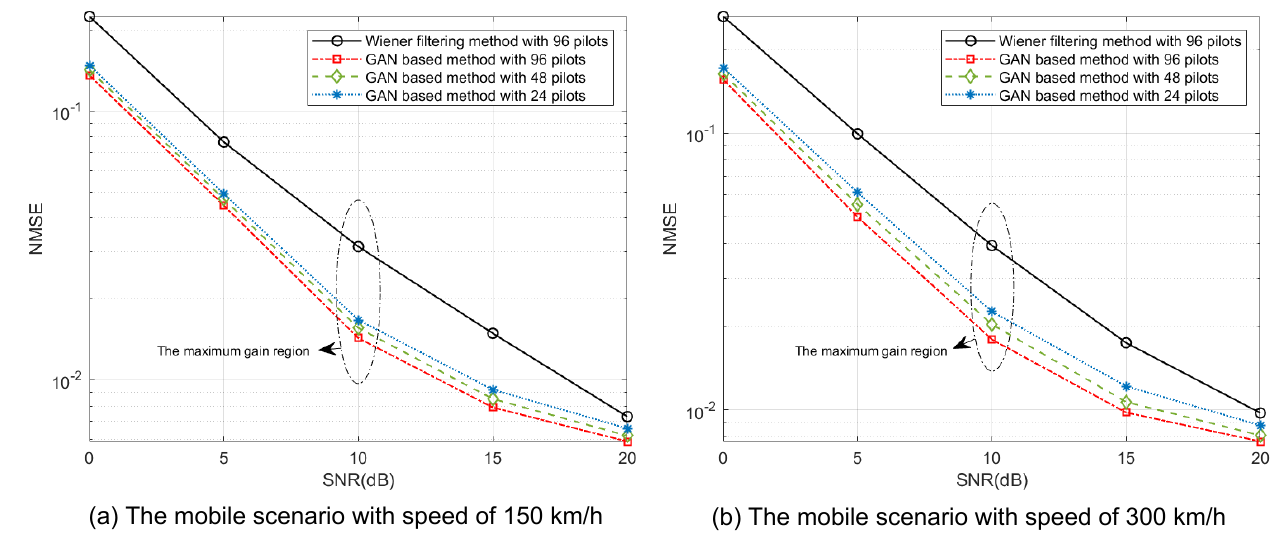
Figure 9. NMSE evaluation of our proposed GAN-based channel estimation